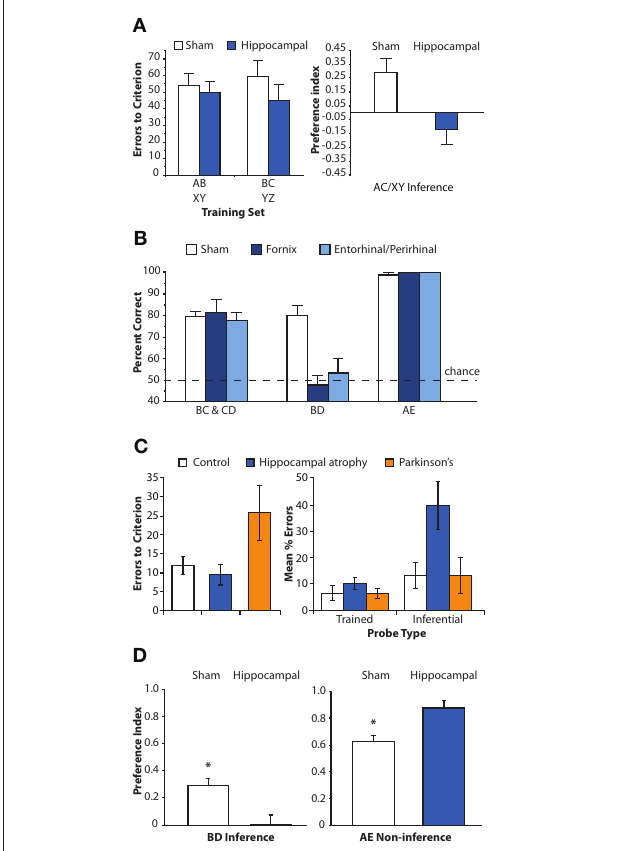
FIGURE 2 | Lesion and neuropsychological studies assessing the critical role of hippocampus in inference. (A) Associative inference task. Left panel: mean number of errors to criterion on training of two sets of overlapping associations (e.g., AB, BC). Right panel: Inference performance as measured by a preference index for indirectly related item (e.g., selecting C when cued with A). White bars denote sham operated control rats; blue bars denote hippocampally lesioned rats. Hippocampally lesioned rats learn individual relationships between item pairs at a rate similar to control rats, but fail on the inference test. Adapted by permission from Bunsey and Eichenbaum (1996), copyright 1996 Macmillan Publishers Ltd. (B) Transitive inference task. Rats with lesions disconnecting the hippocampus from its subcortical (fornix, dark blue bars) or cortical (entorhinal/perirhinal, light blue bars) target structures performed similarly to sham operated control rats (white bars) on trained associations (BC, CD) and novel non-inferential probe trials (AE). However, lesioned rats were severely impaired on inferential probe trials (BD). Adapted by permission from Dusek and Eichenbaum (1997), copyright 1997 National Academy of Sciences, USA. (C) Mean performance of control participants (white bars), patients with hippocampal atrophy (blue bars) or Parkinson’s disease patients (orange bars) in an acquired equivalence task. Patients with hippocampal atrophy reached a criterion level of performance at a rate similar to control participants. In contrast, Parkinson’s disease patients required more extensive training. However, at test, hippocampal patients were severely impaired on inferential probe trials relative to both control participants and patients with Parkinson’s disease. Adapted by permission from Myers et al. (2003), copyright 2003 MIT Press. (D) Post-training hippocampal lesions (blue bars) impaired transitive inference judgments (BD) in mice, but enhanced performance on novel non-inferential probe trials (AE) involving the end items of the hierarchy relative to sham operated animals (white bars). Adapted by permission from DeVito et al.